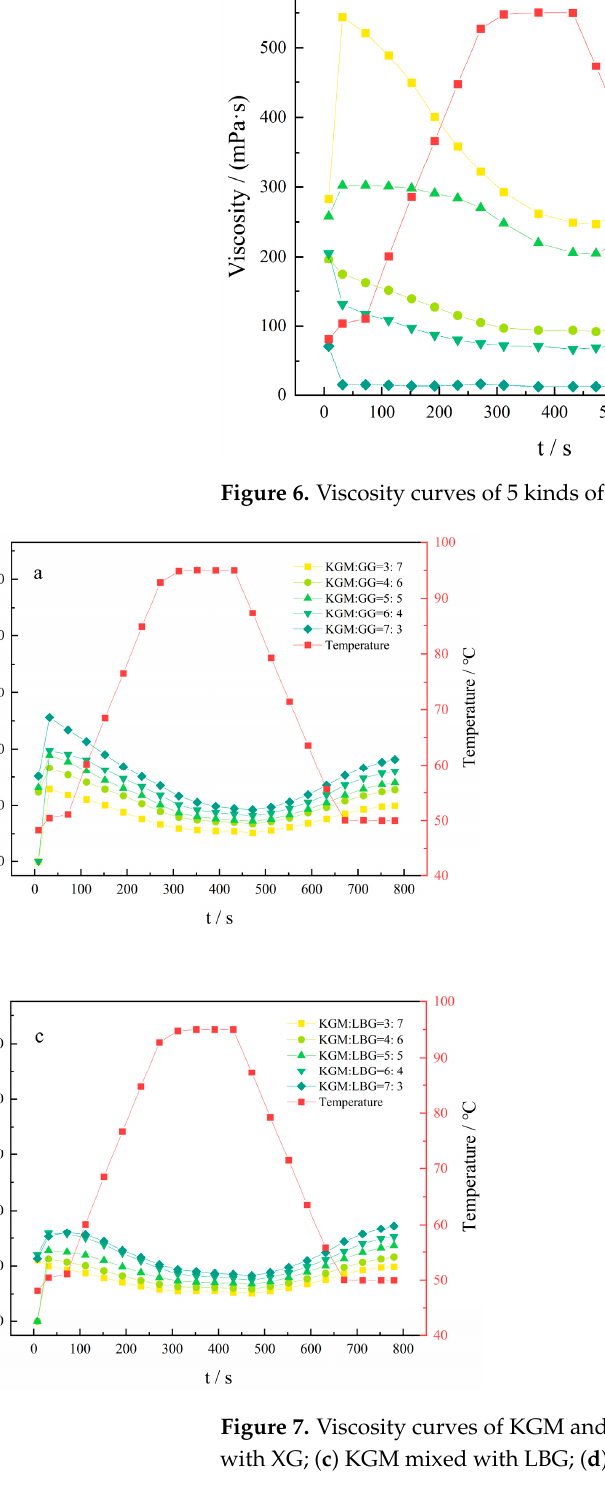
with XG; ( c ) KGM mixed with LBG; ( d ) KGM mixed with KC.